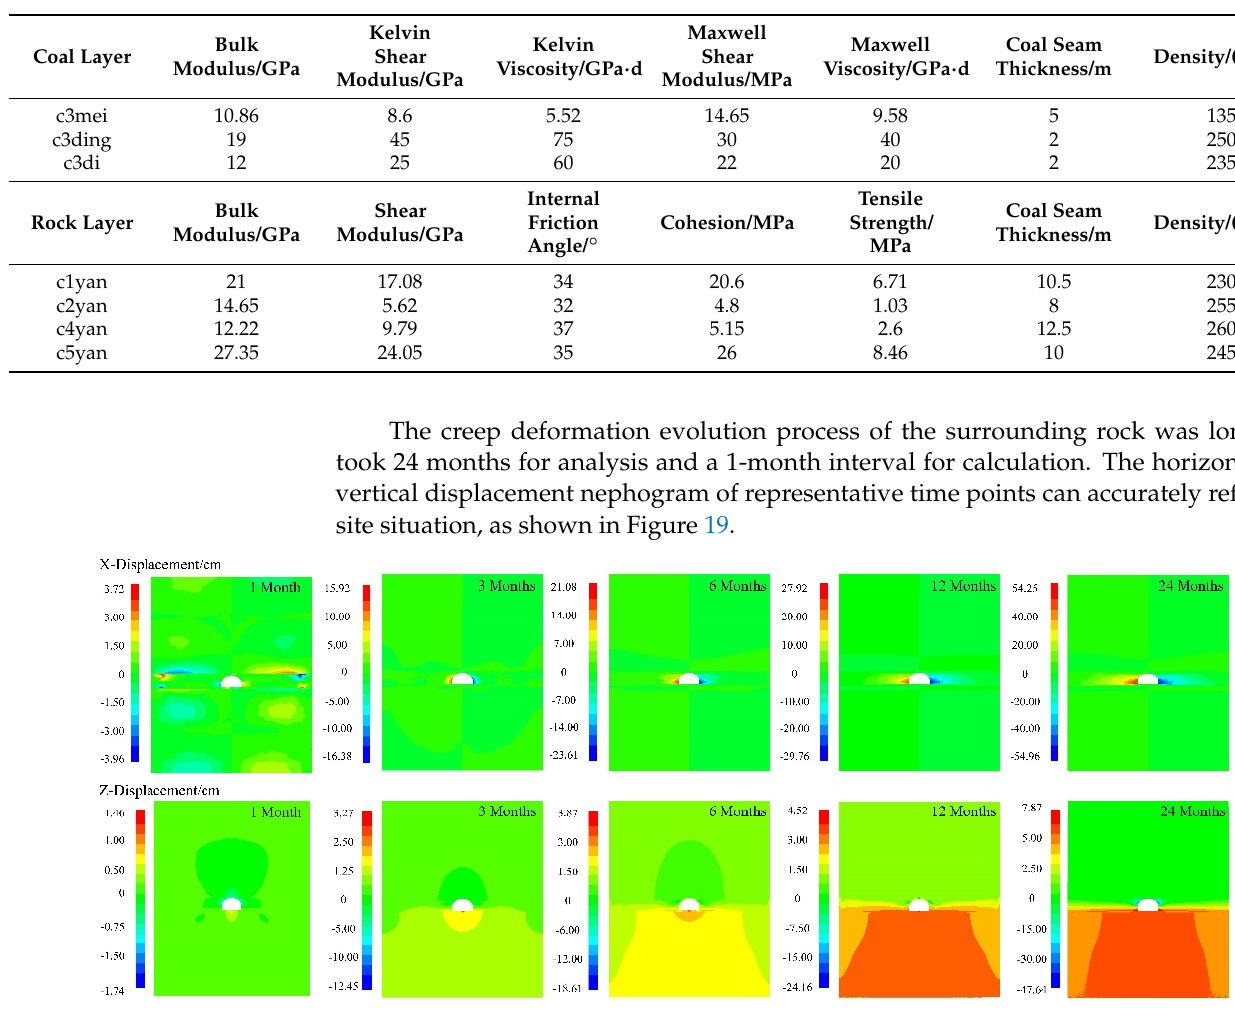
Table 3. parameter measurement of each coal seam.